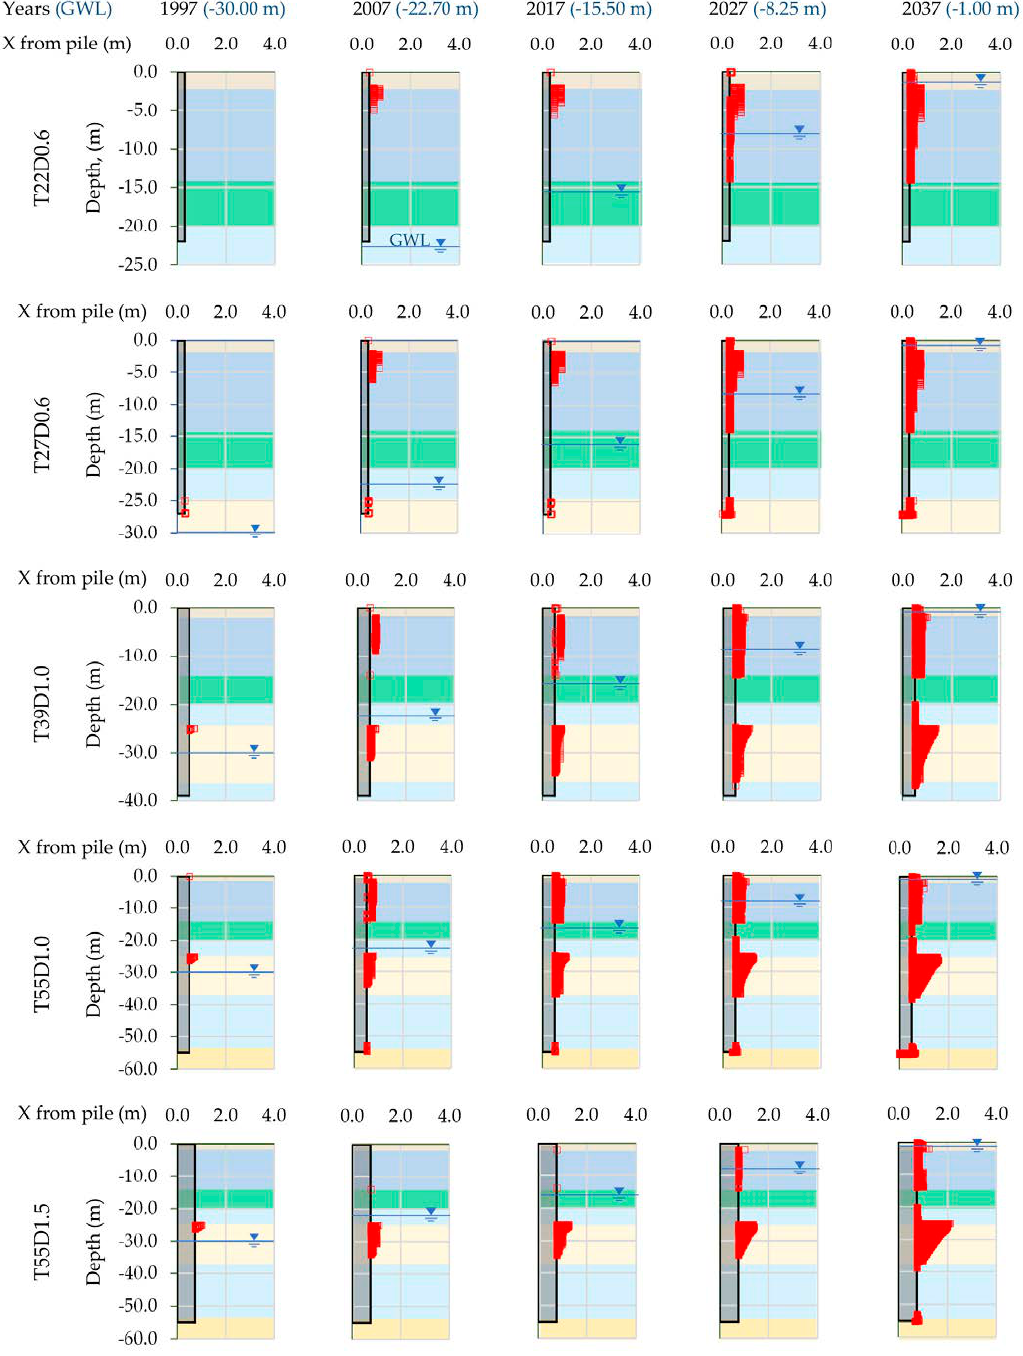
Figure 12. Plastic points along the pile.